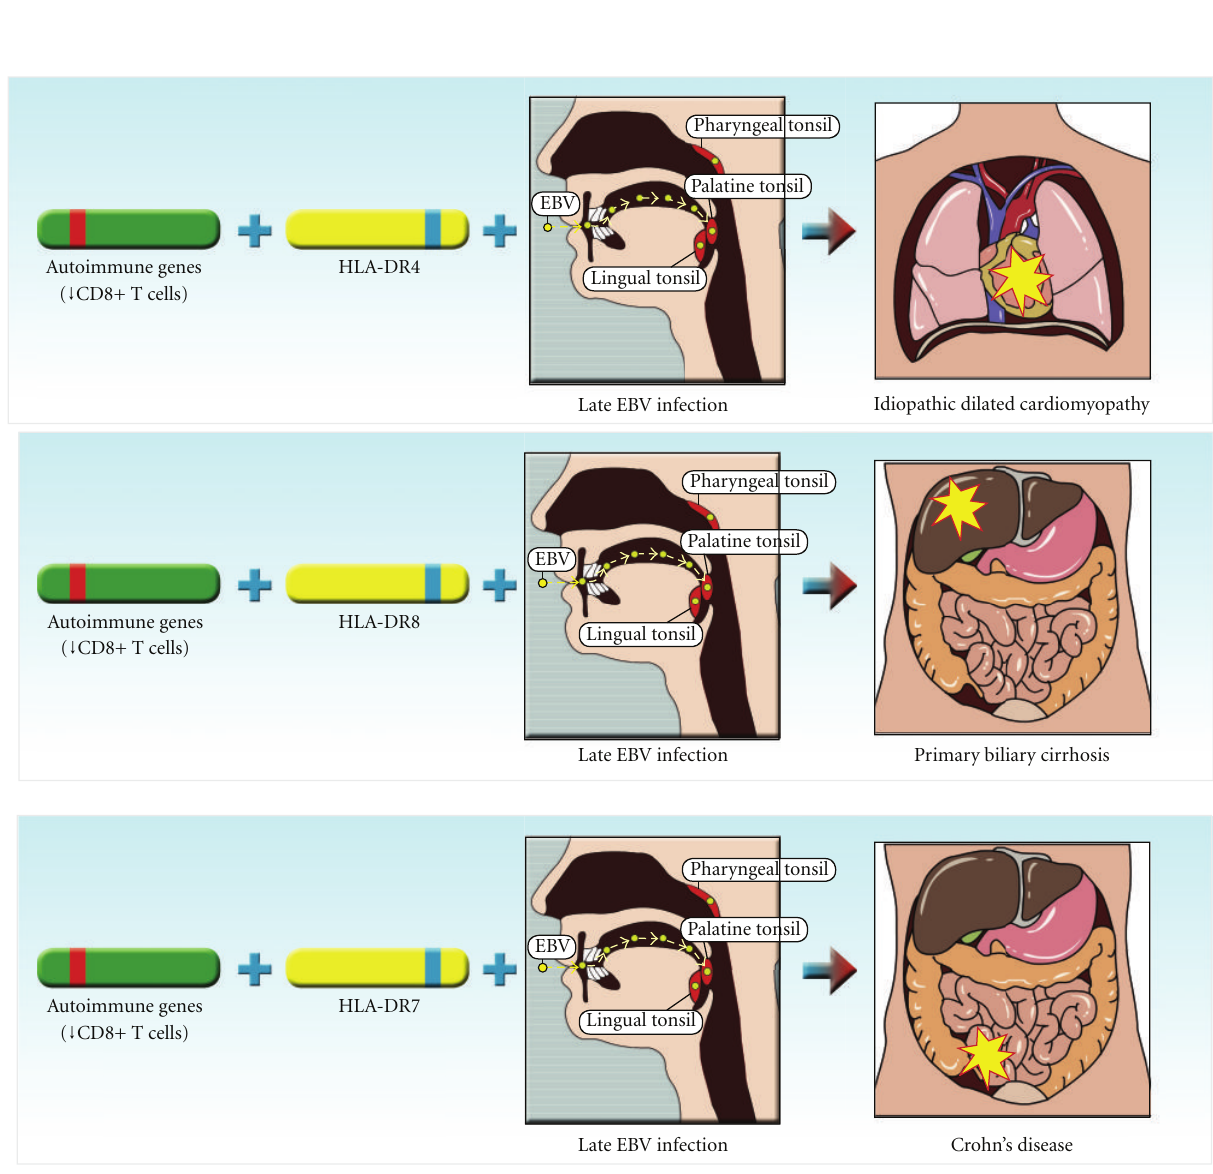
Figure 4: Proposed sequence of events leading to the development of chronic autoimmune diseases. In individuals with a genetic deficiency of CD8+ T cells (carried by “Autoimmune genes”) and with HLA class II genes predisposing to idiopathic dilated cardiomyopathy (HLA-DR4 [206]), primary biliary cirrhosis (HLA-DR8 [207]), and Crohn’s disease (HLA-DR7 [208]), primary EBV infection, particularly if delayed (Late), leads to the infection of autoreactive B cells, which accumulate in the target organ where they reactivate autoreactive T cells that orchestrate an autoimmune attack on the organ. For simplicity these depictions focus on the role of CD8+ T-cell deficiency, EBV infection and selected HLA alleles and do not include interactions with other genetic and environmental factors that may also contribute to the pathogenesis of autoimmune